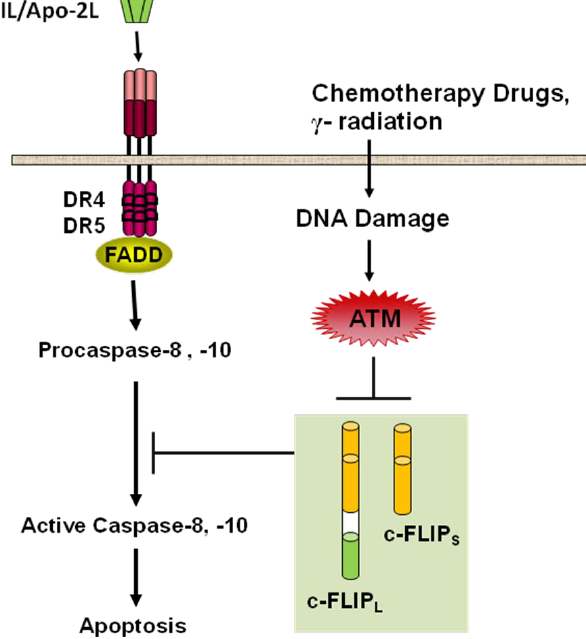
Figure 4. ATM kinase activity downregulates c-FLIP connects DNA damage signaling to TRAIL-induced apoptosis signaling pathway. DNA damaging agents induce ATM activation, which promotes c-FLIP c-FLIP downregulation through an unknown mechanism (Stagni et al. S